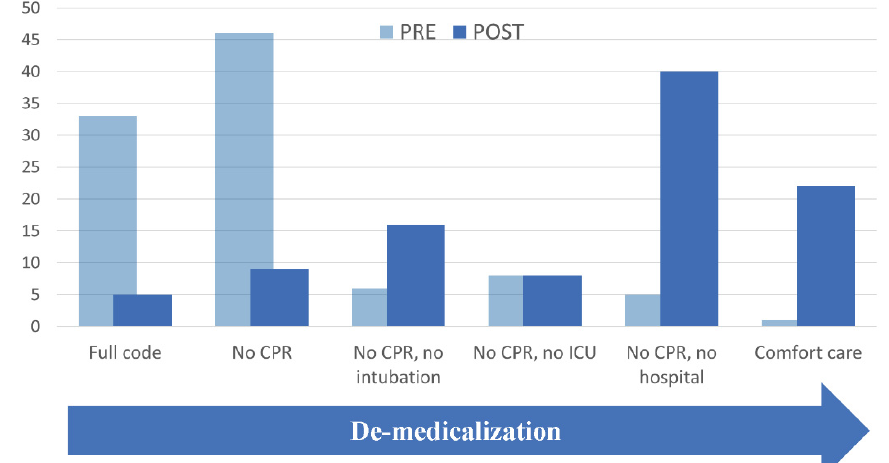
Figure 4. Decisions pre- vs. post-MED-LTC consultation ( n = 63).